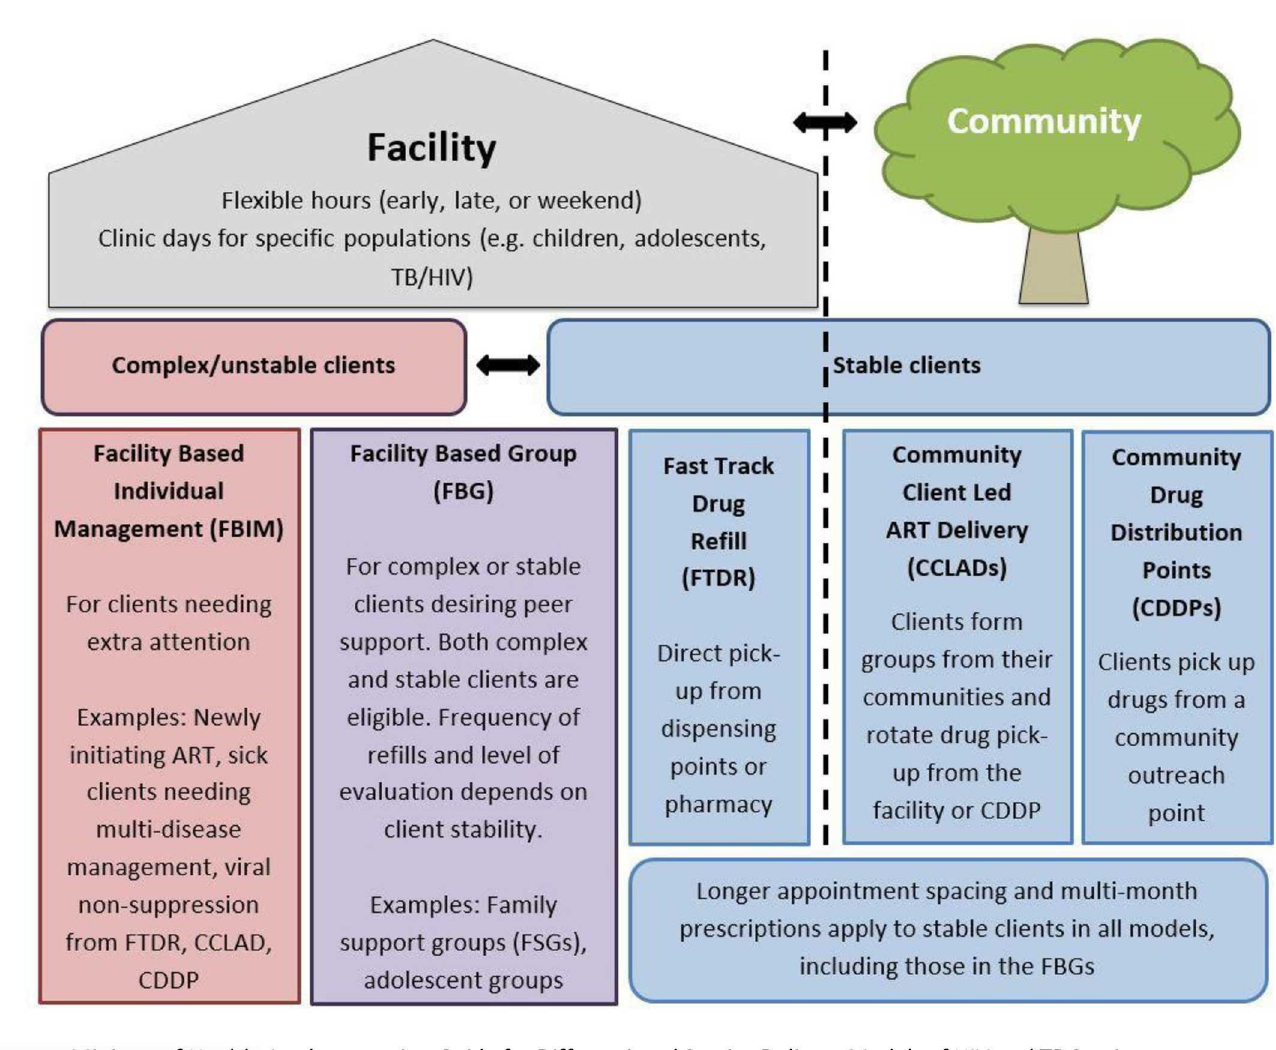
Fig 1. The five differentiated ART models in